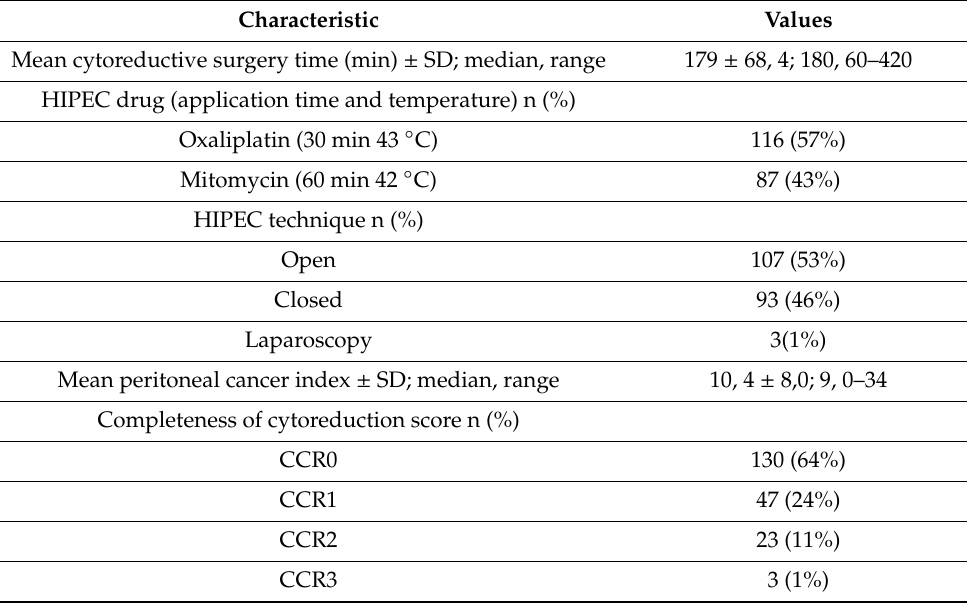
Table 2. Characteristics of cytoreductive surgery (CRS) and hyperthermic intraperitoneal chemotherapy (HIPEC) procedures.